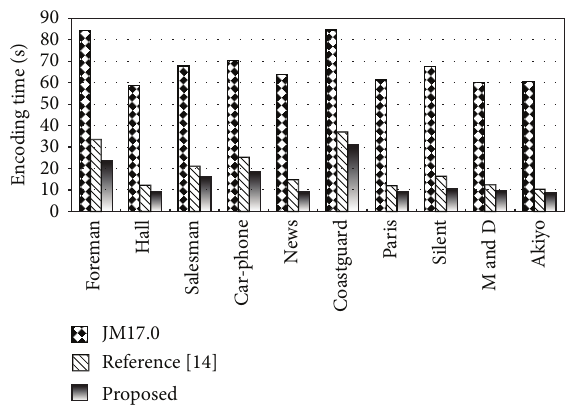
region (𝑀(𝑥, 𝑦) = 1) , the macroblock has temporal visual characteristics. 𝑆(𝑥, 𝑦) = 1 means that the macroblock chooses the inter 8 prediction mode and belongs to temporal visual characteristic saliency region.